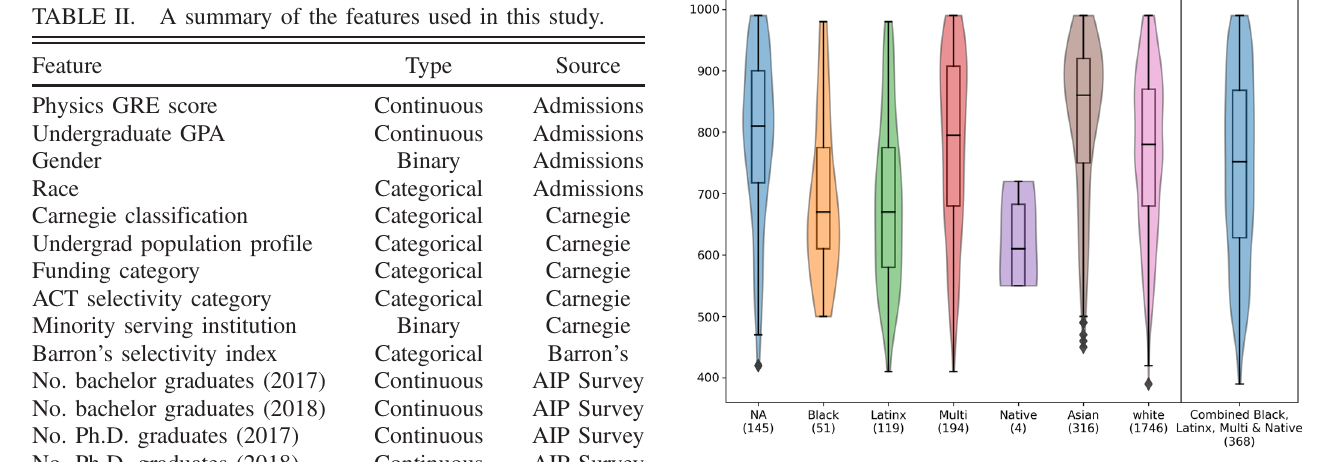
FIG. 2. Estimated P-GRE distributions by racial and ethnic groups (number of applicants indicated in parenthesis). Note that the combined distribution normalizes the differences between the combined